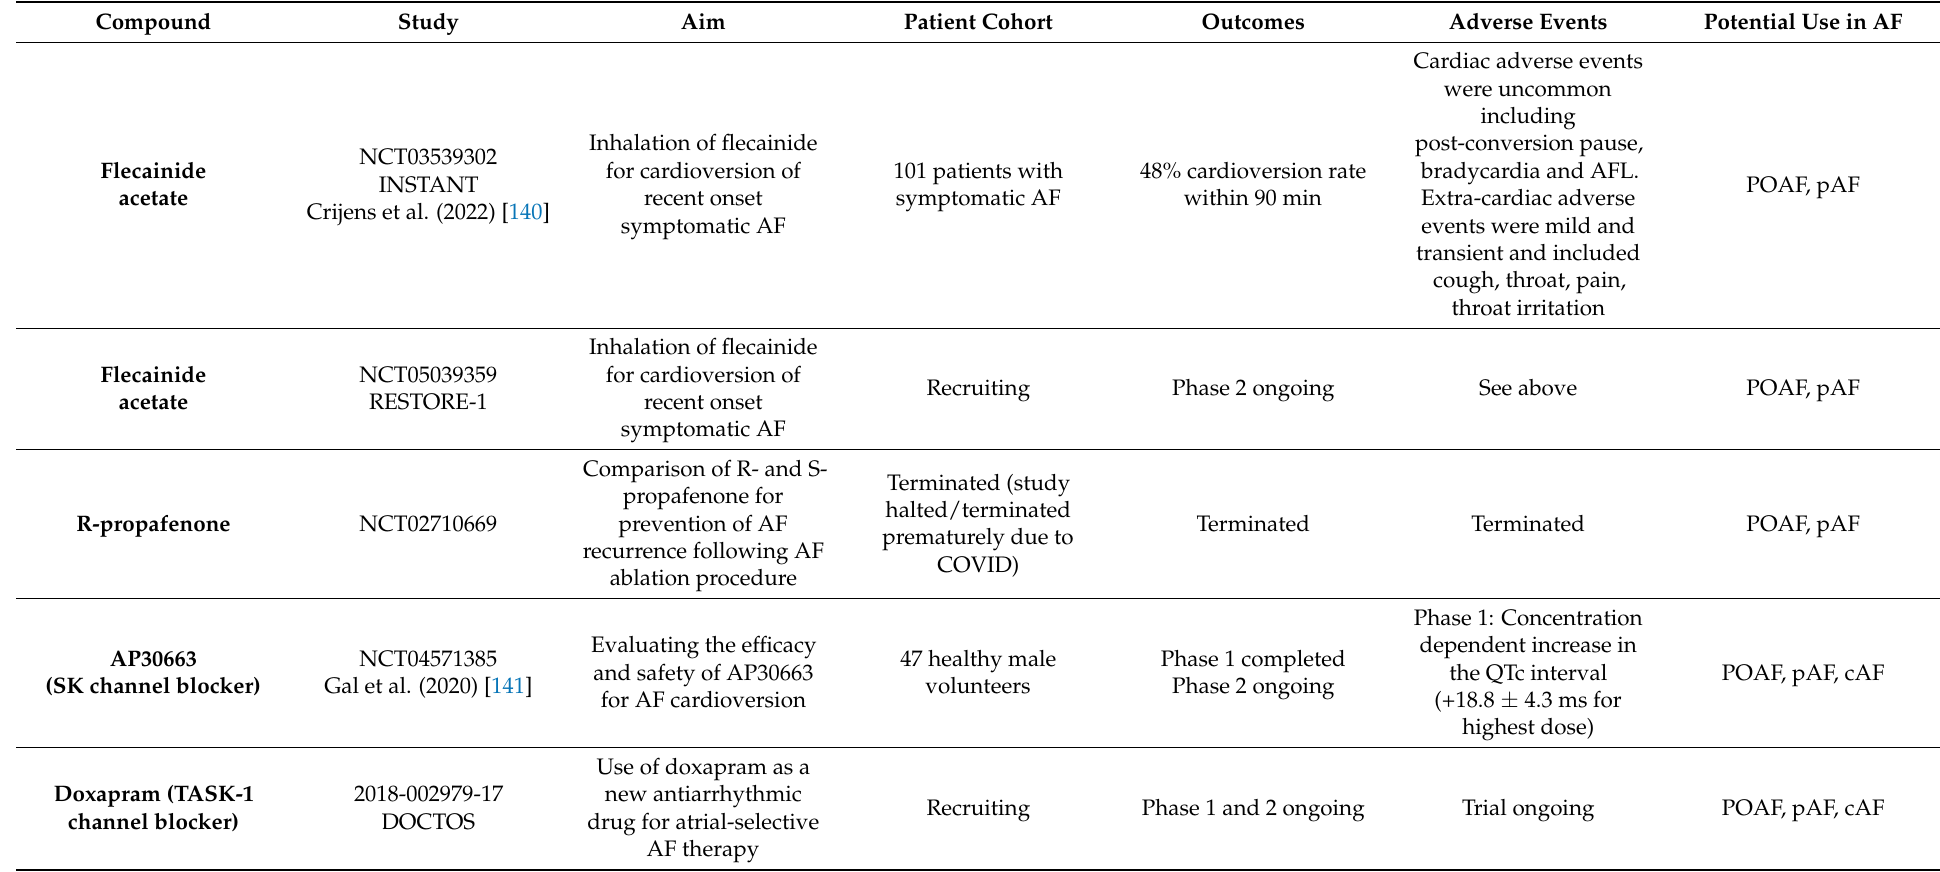
Table 2. Clinical evidence of antiarrhythmic efficacy of emerging drugs for atrial